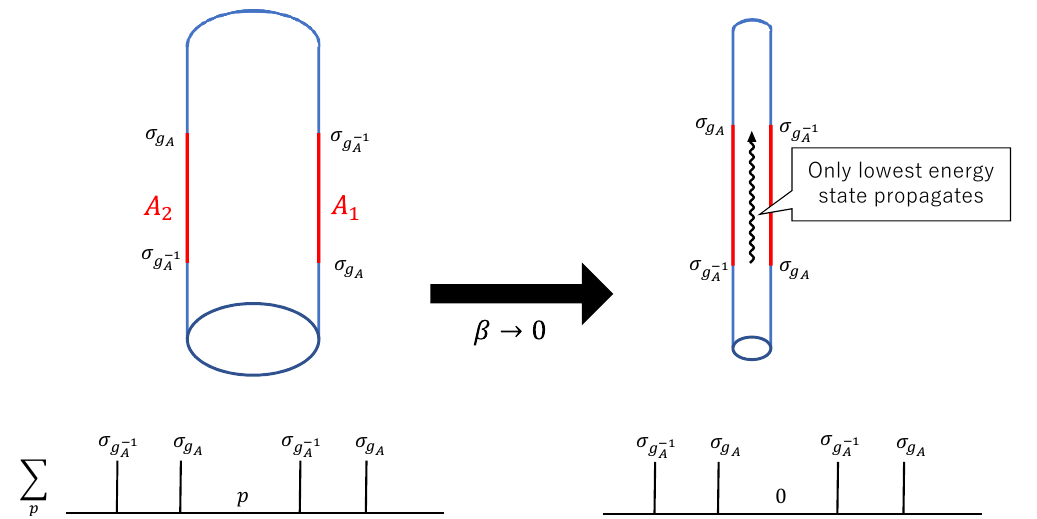
; (cid:27) g , f (cid:27) ; (cid:27) g g becomes much g (cid:0) 1 A g (cid:0) 1 A A A